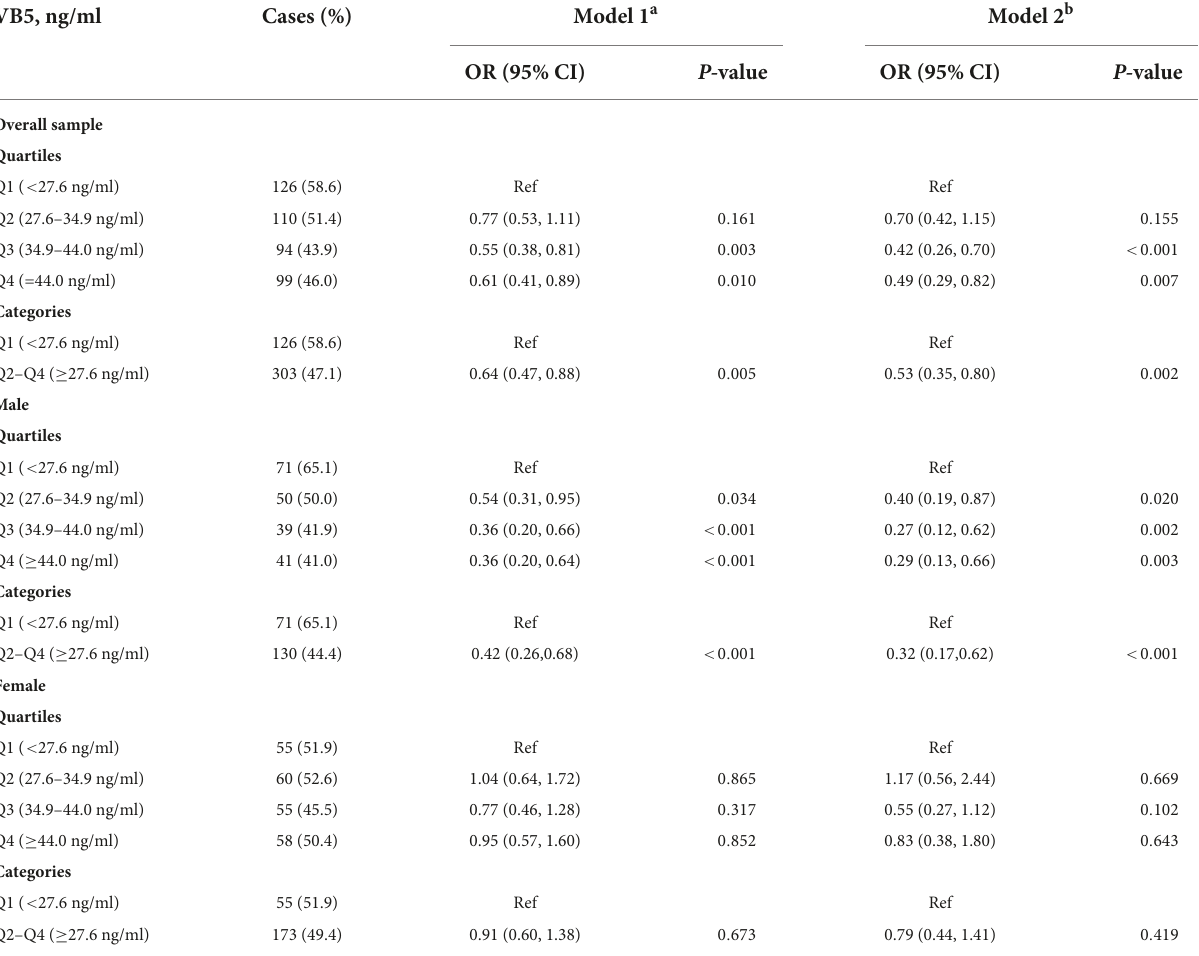
TABLE 2 Association of vitamin B5 with risk of coronary heart disease